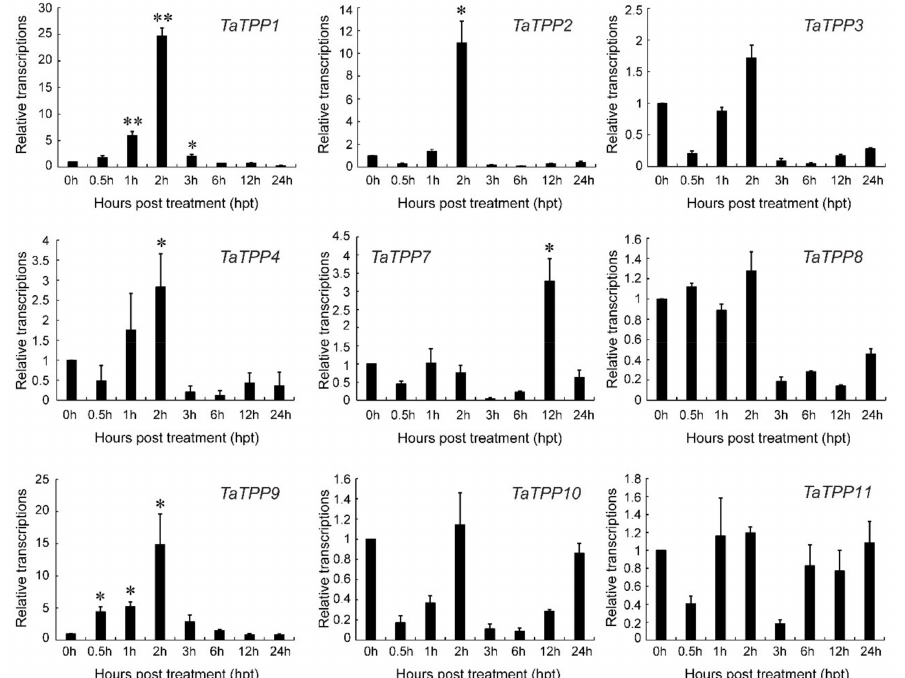
Figure 10. Relative transcript profiles of TaTPPs in response to salt stress. The relative transcripts of all genes were analyzed using qRT-PCR. The relative transcript levels of TaTPPs were measured using the comparative threshold (2 − ∆∆ CT ) method. Data normalized with the transcripts of wheat elongation factor, TaEF-1 α . The 0 h post treatment was used as a control and standardized with 1. Values represent the mean ± SD from three independent biological samples. Asterisks ( p < 0.05) or double asterisks ( p < 0.01) designate significant differences from 0 hpt by the Student’s t